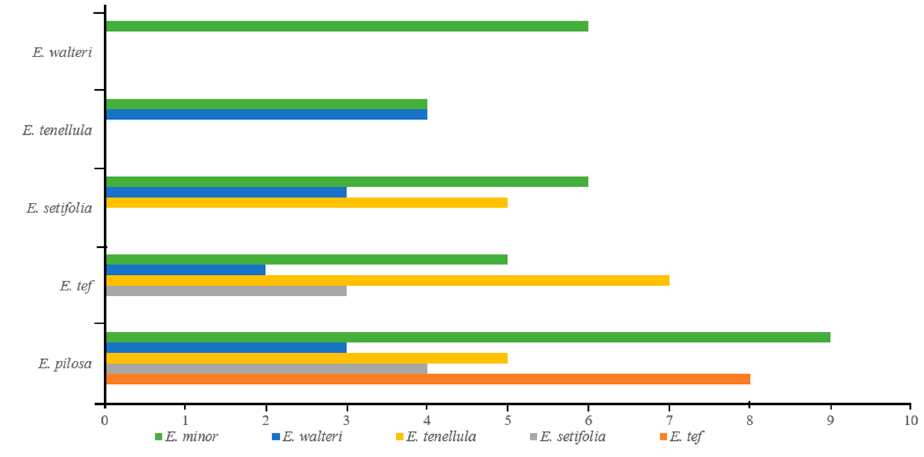
Figure 3. Shared SSRs among Eragrostis species.